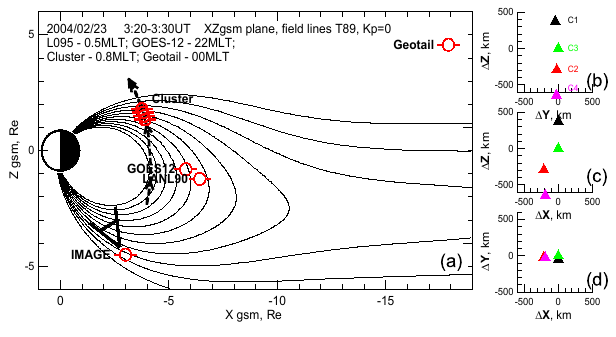
Fig. 1. (a) Spacecraft locations in the XZ GSM projection, (b–d) zoomed-in Cluster XY,XZ,YZ projections show the pearl-on-string